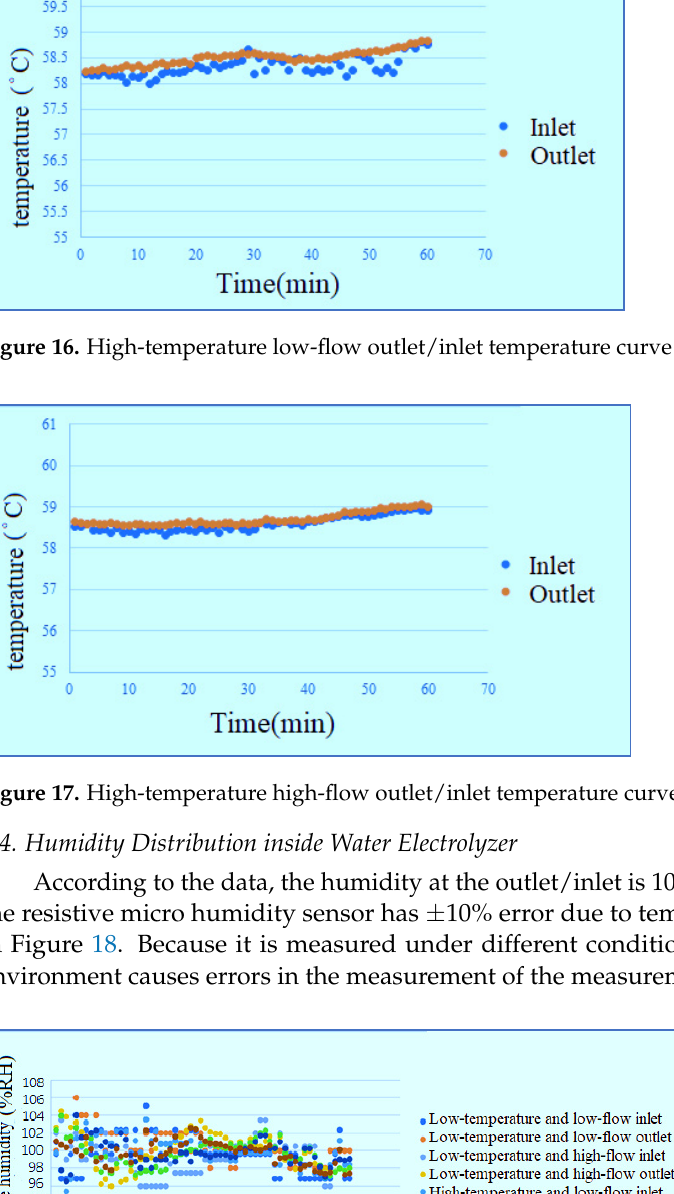
Figure 15. Low-temperature high-flow outlet/inlet temperature curve diagram.